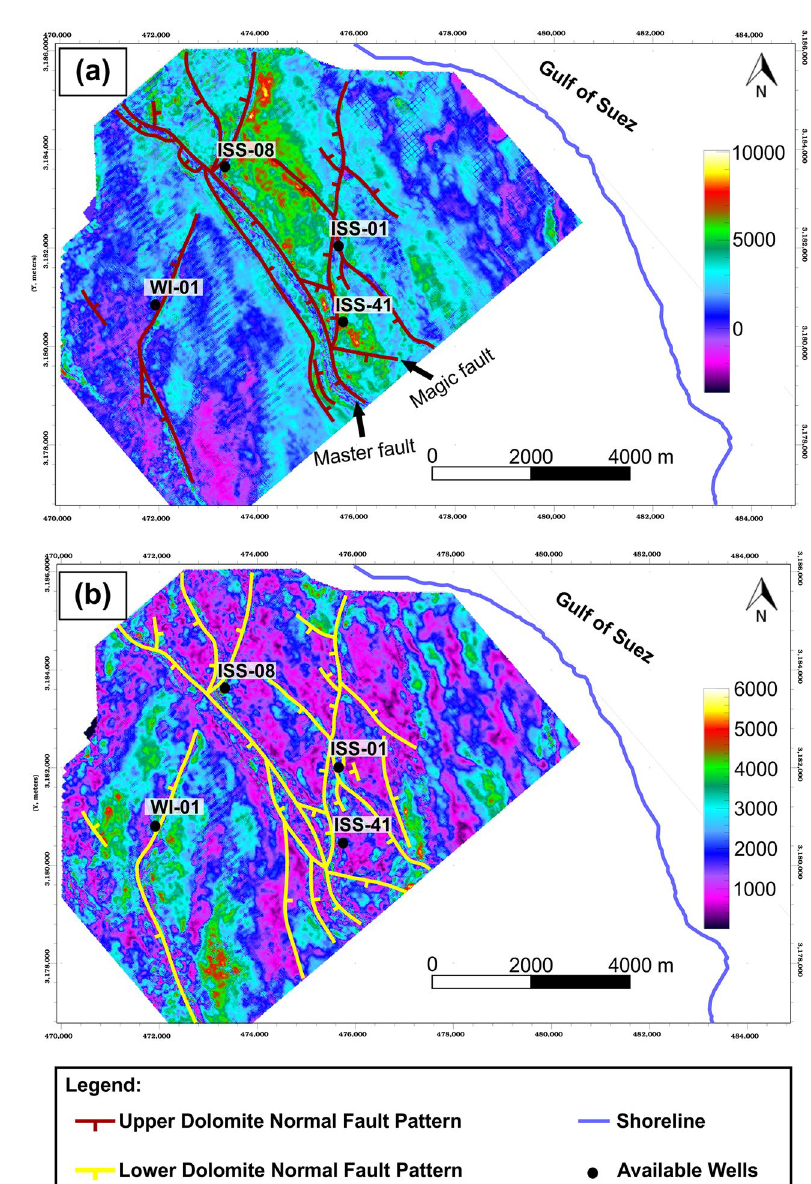
Fig. 14 RMS amplitude horizon attribute for a 12 ms time gate within a Upper Dolomite res- ervoir with fault pattern and b Lower Dolomite reservoir with fault pattern. They are demon- strating that the Upper Dolomite facies is better than the Lower Dolomite facies in the central and eastern parts of the Issaran field. However, the Lower Dolo- mite reservoir is better in West Issaran. Additionally, the Upper Dolomite facies is controlled by the structure more than the Lower Dolomite